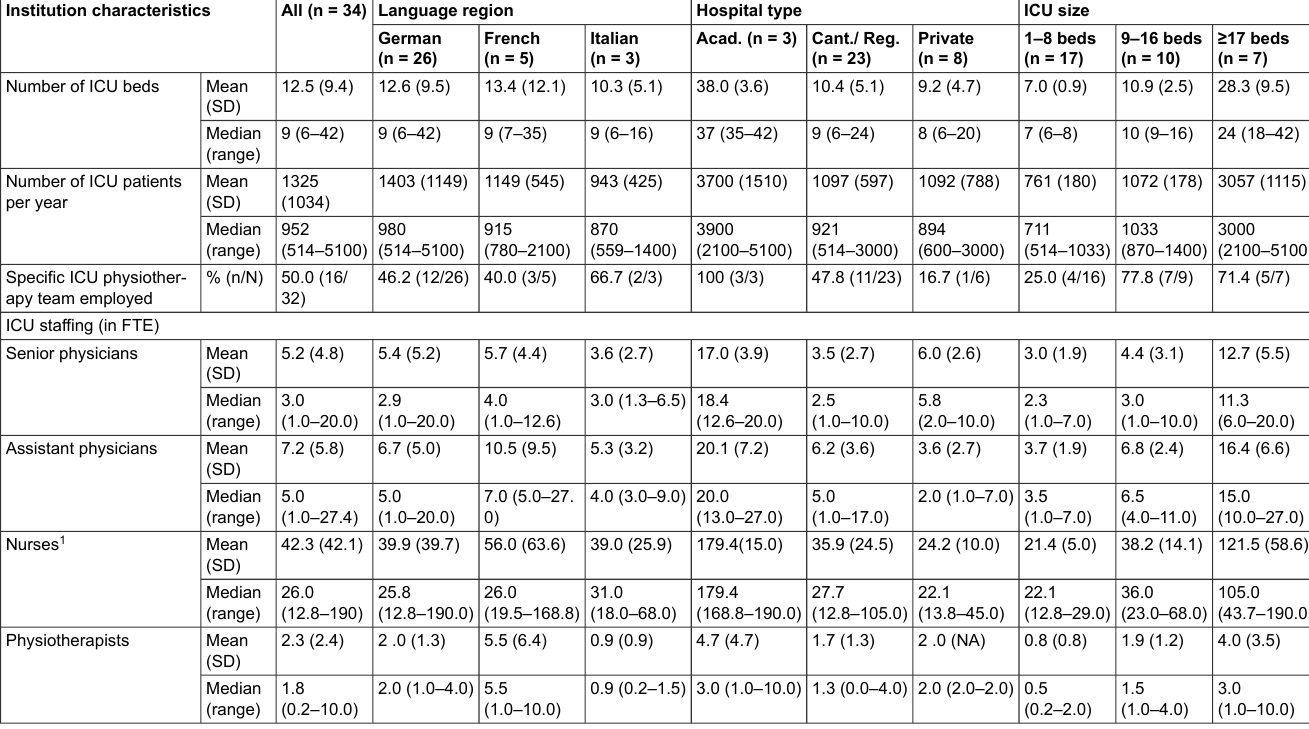
Table 1: Characteristics of participating intensive care units (ICUs) by language region, hospital type, and ICU size (ICUs caring for adults only). Institution